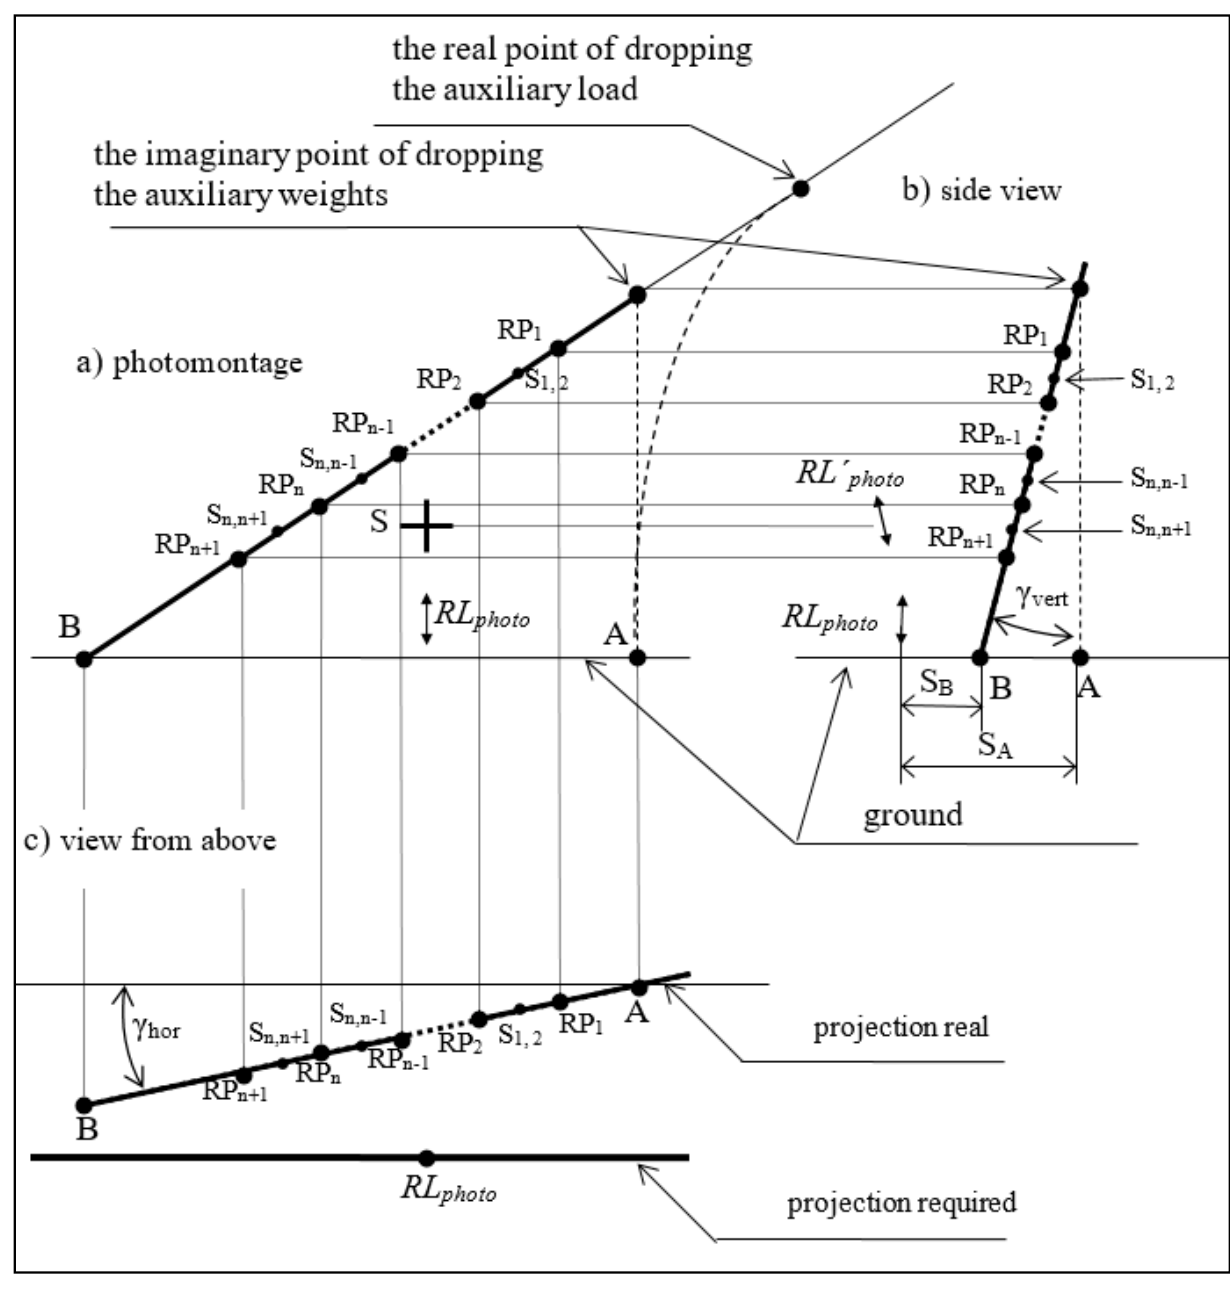
Figure 8. Graphical representation of reference points (RPs) (source: The authors of this article).